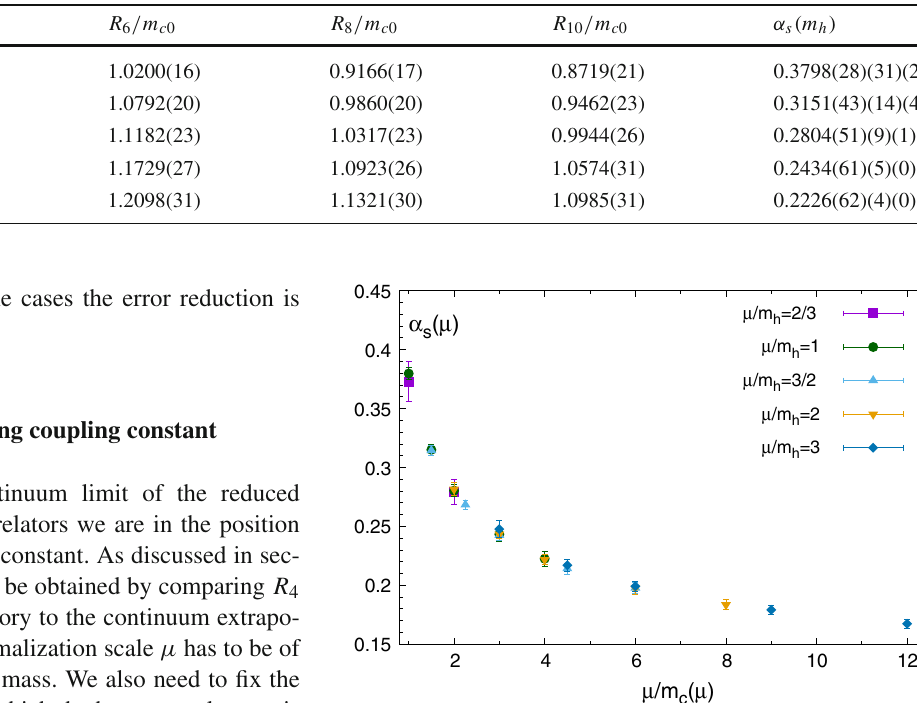
quadrature. The different symbols in the figure correspond to α s (μ) obtained from R 4 for different choices of μ/ m h and agree well within the estimated errors. This is an impor- tant consistency check for our procedure and serves as